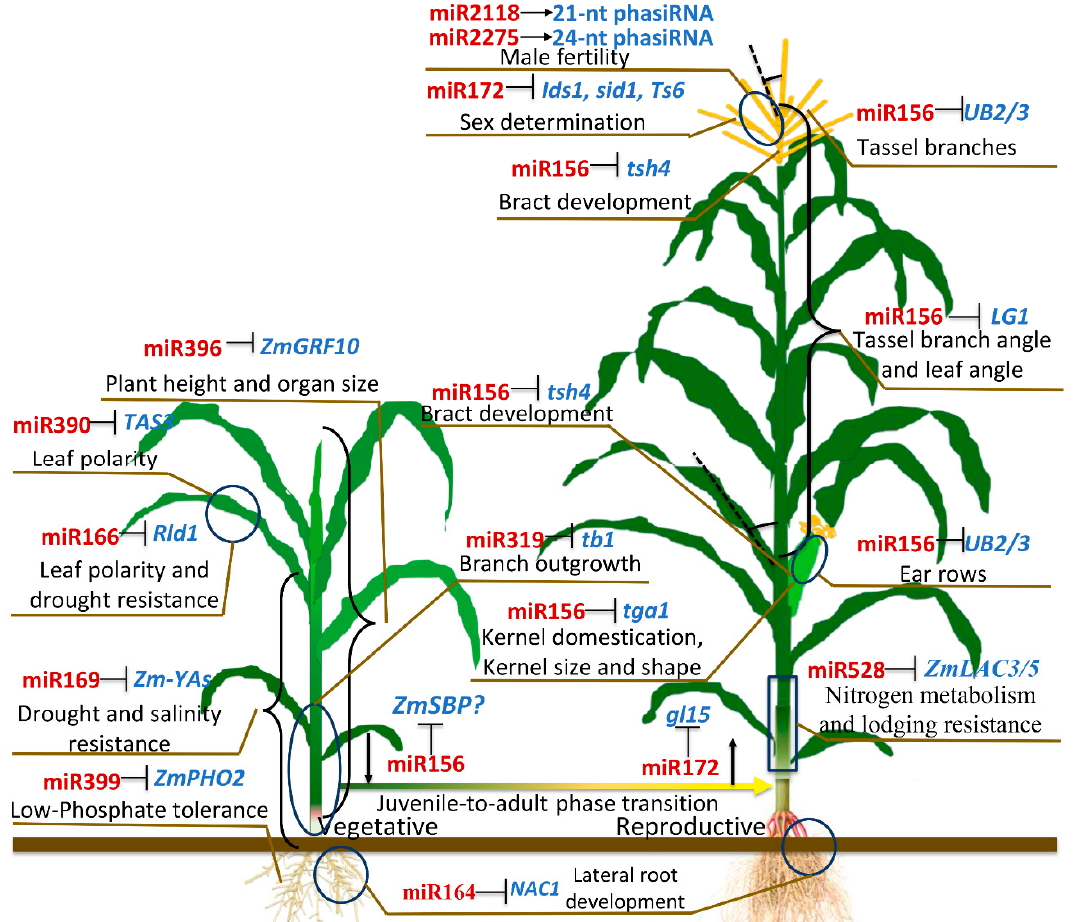
Figure 4. Summary of functionally validated miRNAs and their targets in maize. Nine miRNAs (in red font) and three phasiRNAs (in red font) that regulate specific agronomic traits (in black font) by inducing their targets (in blue font) gene silencing. Question marks indicate that specific ZmSBP taking part in juvenile-to-adult phase transition is not known.